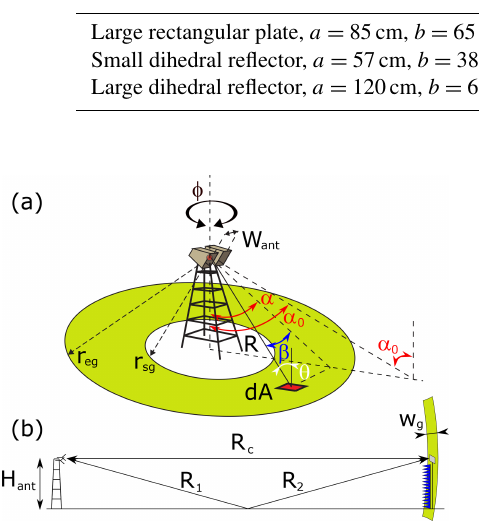
Figure B1. Connection scheme of scatterometer and correspondence S parameters to polarization channels for transmit (TX) and receive (RX). (a) Both dual-polarization broad-band antennas, one for TX and the other for RX, are connected to the VNA as indicated (Keysight Technologies, 2017). Arrows indicate direction of signal. (b) Overview correspondence of four VNA S parameters to the four polarization channels. Table B1. Deployed reference standards and their bandwidths of validity concerning plane wave (PW) and size-to-wavelength criteria. Distance R 0 PW criteria met for